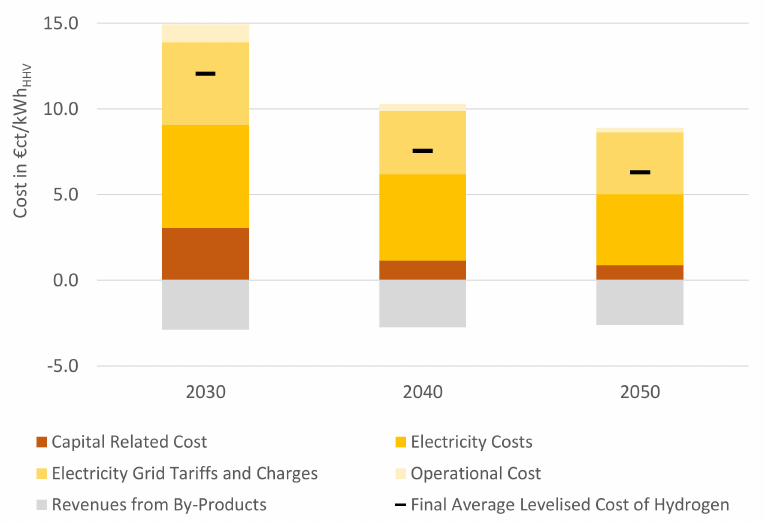
Figure 8. Averaged hydrogen production cost structure for scenario